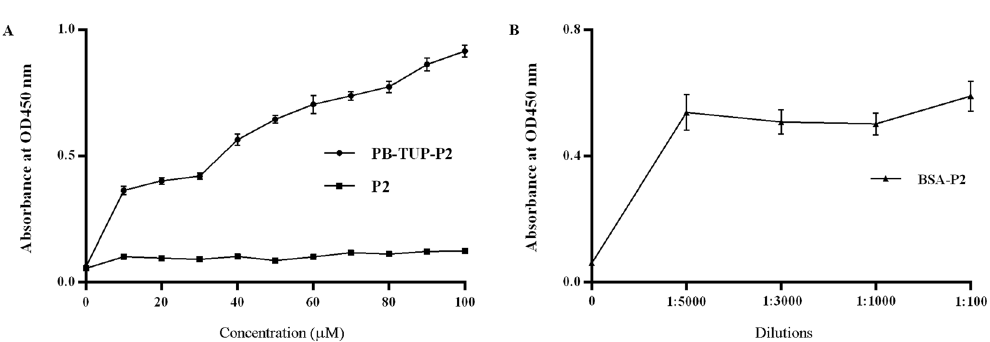
Figure 8. Detection of native peptide, PB-TUP fused P2 and BSA conjugated P2 by ELISA. ( A ) Binding property of P2 and PB-TUP-P2 was studied by direct ELISA using these two peptides as capture agents. P2 absorbed weakly to polystyrene surfaces, while the fused peptide PB-TUP-P2 showed a strong binding ability to polystyrene in a concentration dependent manner. ( B ) BSA conjugated P2 was used as coating agent and P2 specific antibody was used to investigate the binding of BSA-P2. We used the dilution from 1:100 to 1:5000 and not any difference was found from the ELISA value.